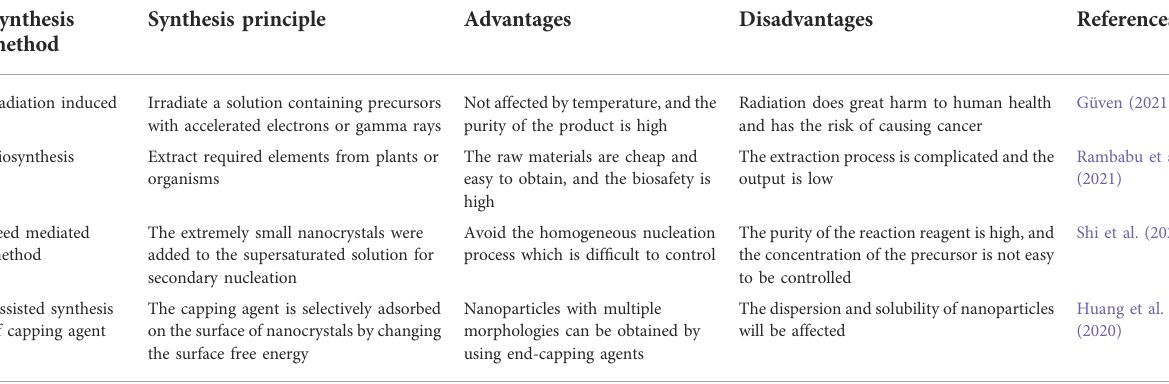
TABLE 1 Synthesis methods and advantages and disadvantages of Inorganic